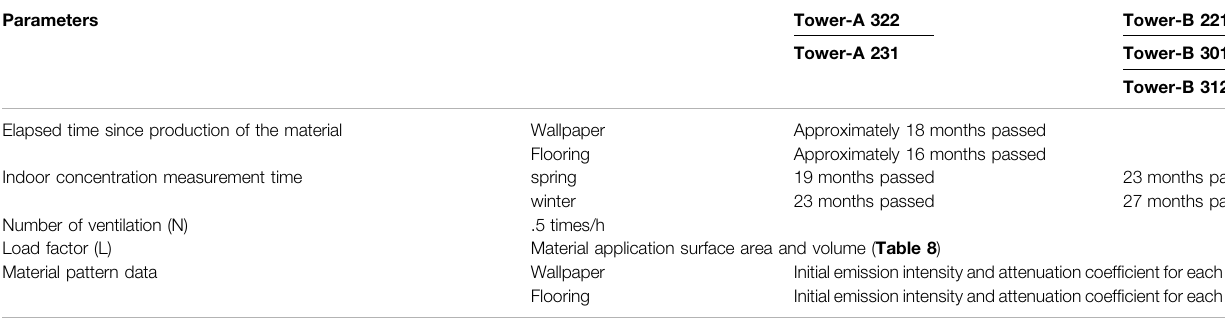
TABLE 8 | Parameters for prediction of indoor concentration.